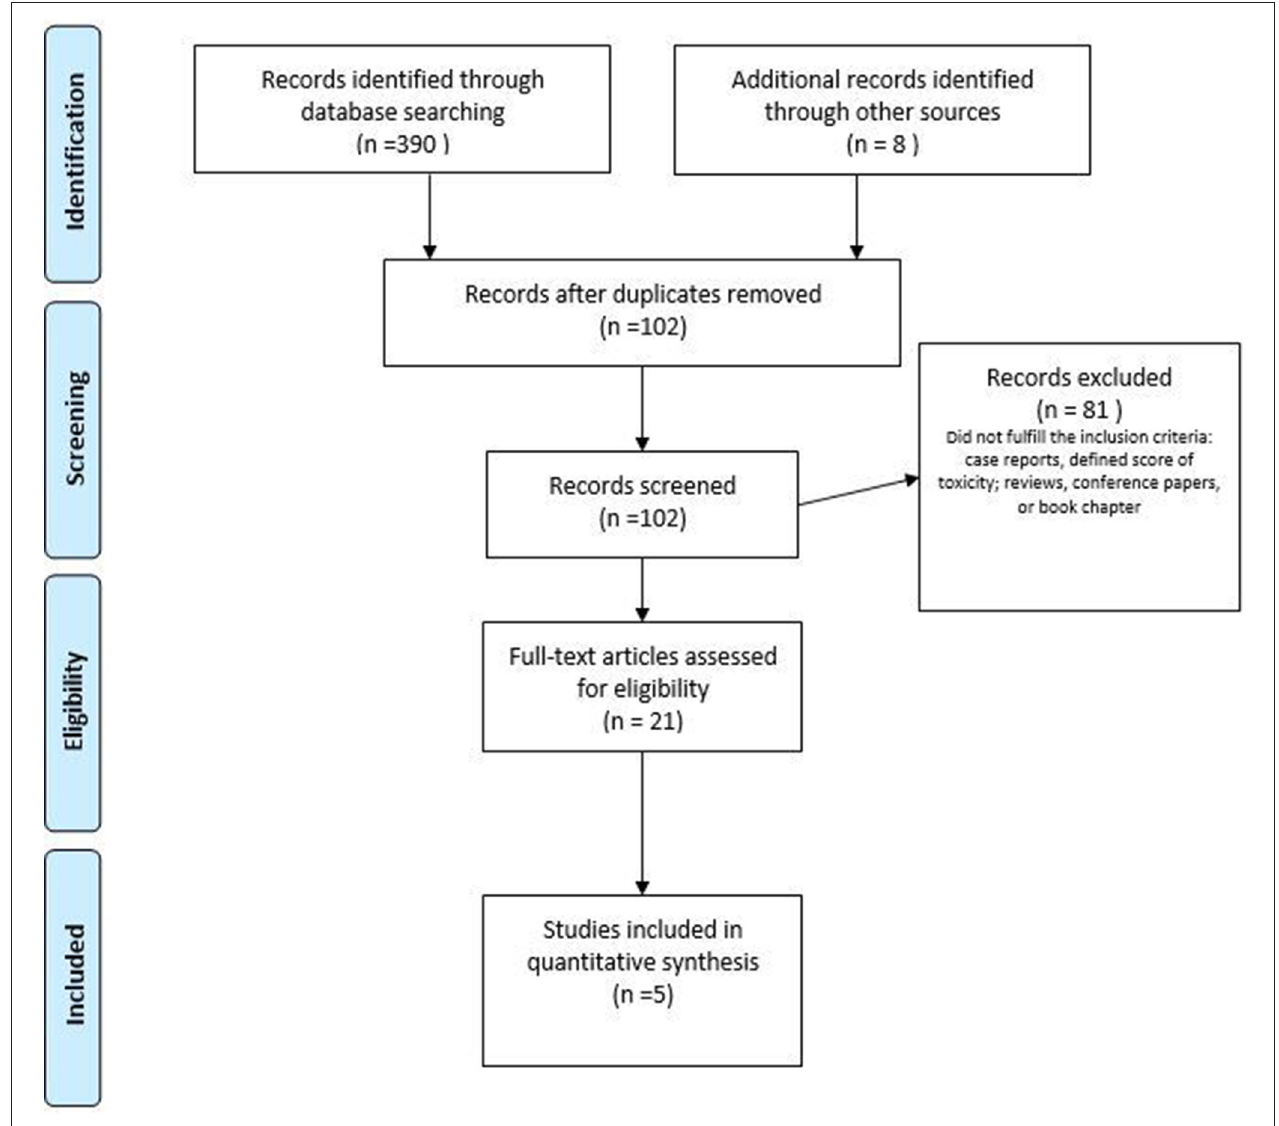
FIGURE 2 | PRISMA flow diagram of the study selection process for pelvic floor muscle training (PFMT) as conservative management of sexual dysfunction after radiotherapy (RT) . Adapted from